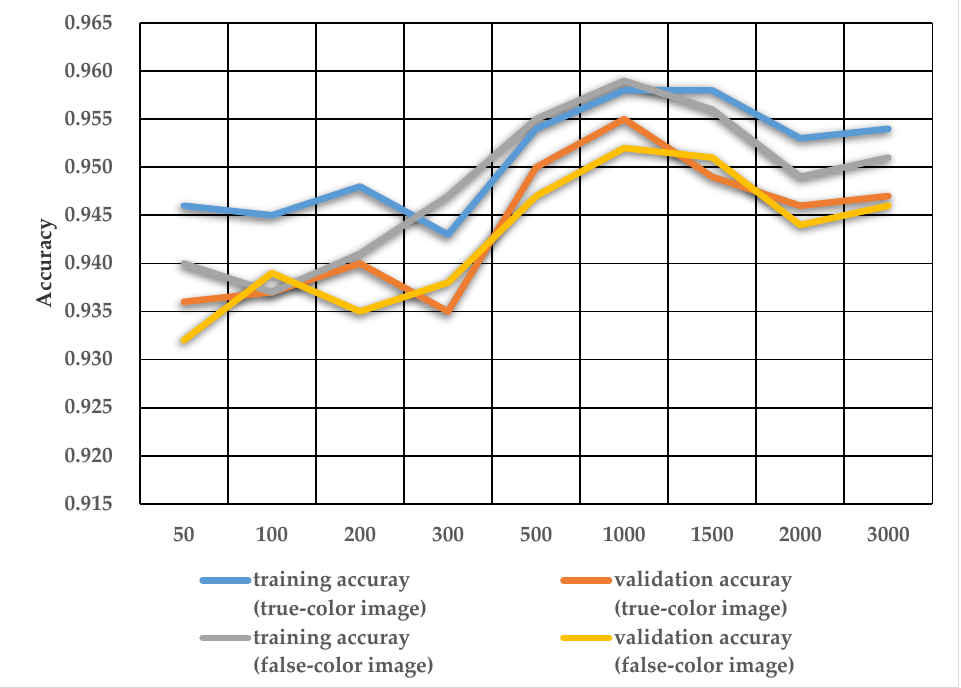
Figure 9. Training and validation accuracies of the true-color image and false-color image under different batch sizes.